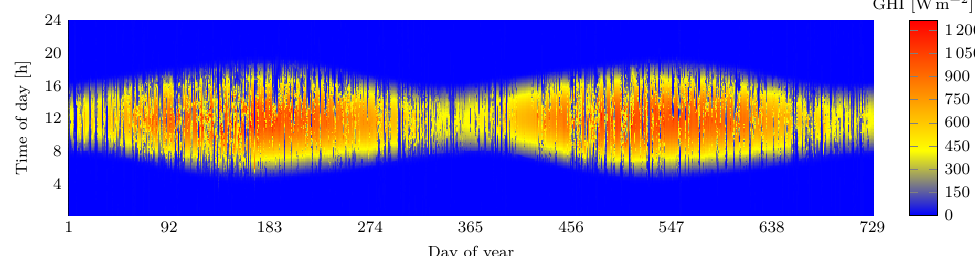
Figure 2. GHI data covering the years 2018 and 2019. Measurements are taken at PROMES-CNRS laboratory, located in Font-Romeu-Odeillo-Via (Occitania region, southern